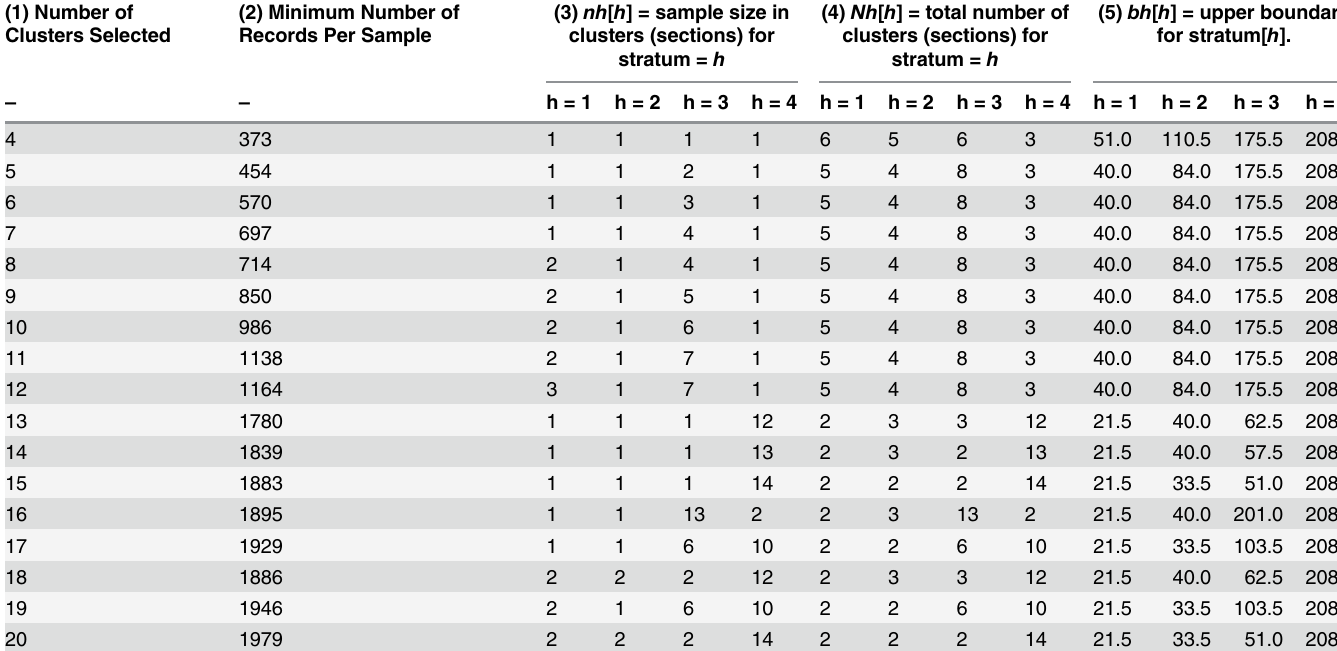
Table 3. Optimal cluster allocation as a function of sample